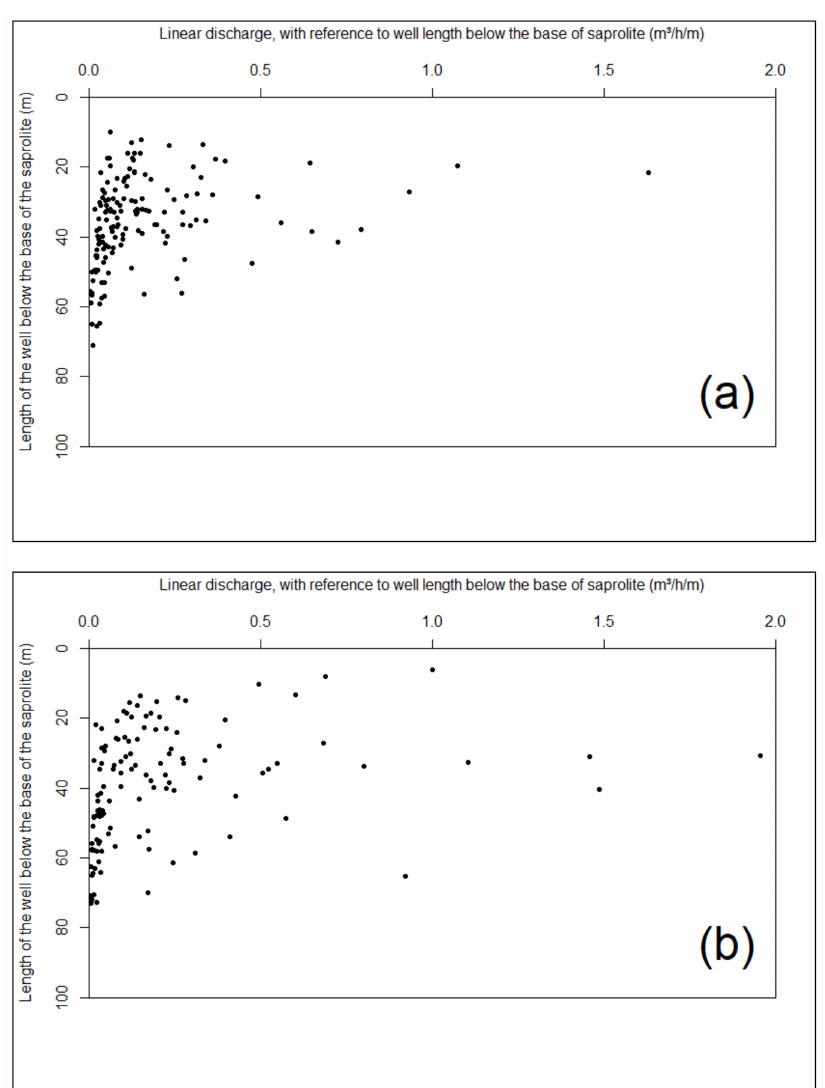
Figure 8. Linear discharges (X; m 3 /h/m), computed with reference to well length below the base of the saprolite (Y; m), for the lithologies ( a ) Charnockitic orthogneiss and Chanockites (N = 145) and ( b ) Biotite granodiorites and Biotite metagranodiorite (N =